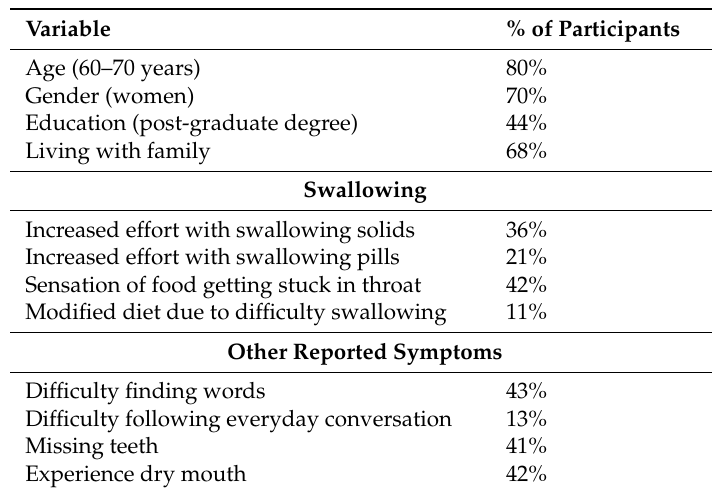
Table 2. Participant demographics and descriptive data. Participant data results from phase 2